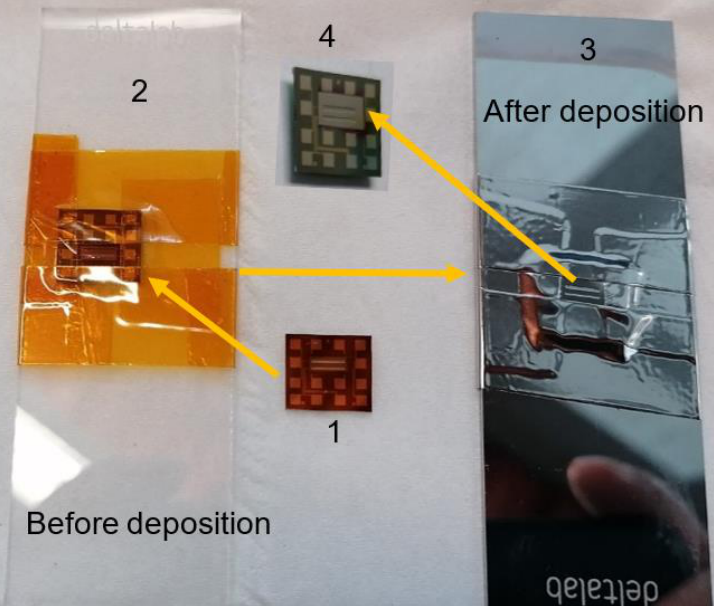
Figure 1. The preparation of thin film on chip: 1, the chip; 2, chip with attached shadow masks; 3, chips after deposition; and 4, chip with defined thin film ready for test.